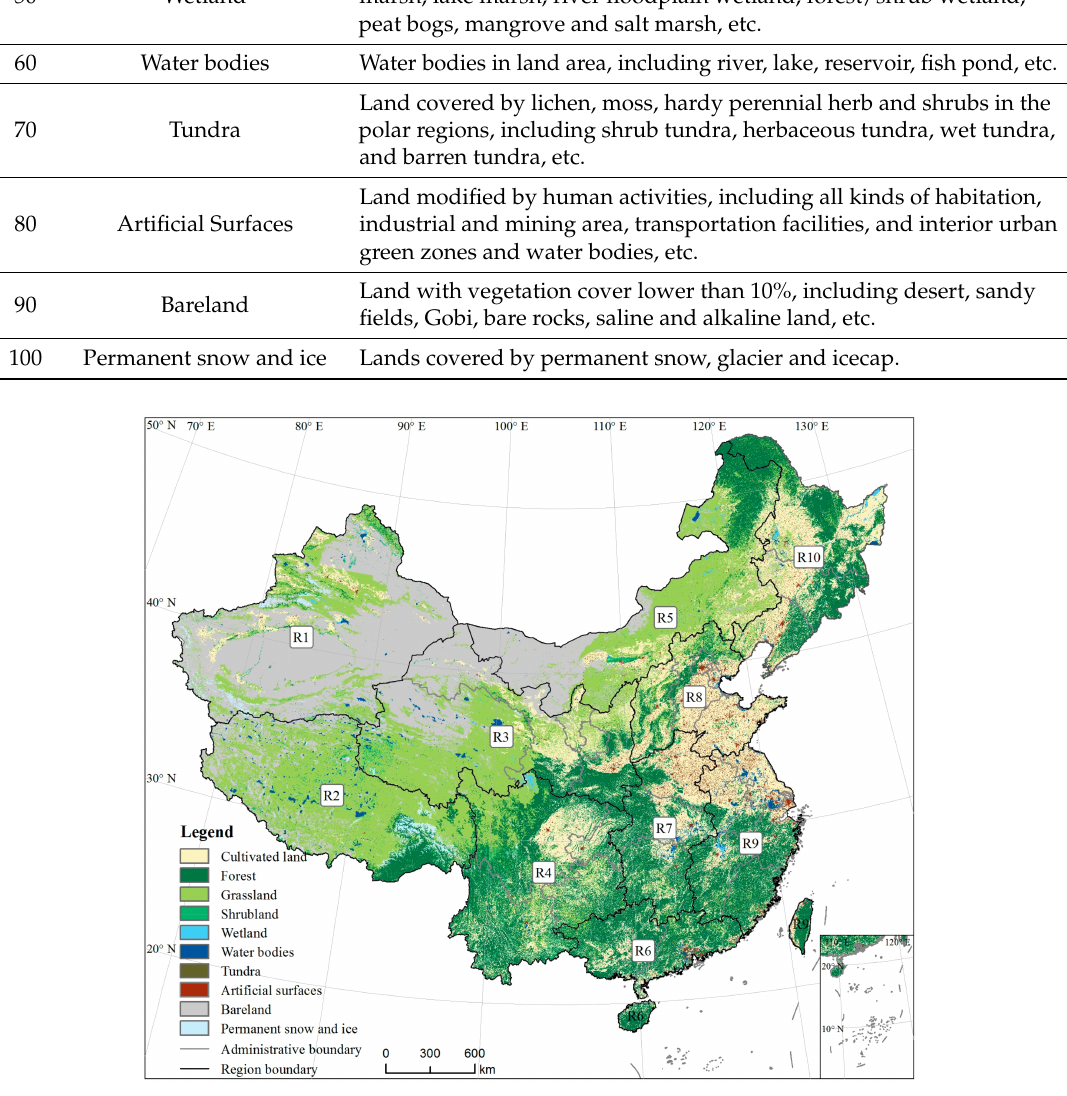
Figure 1. Regional stratification for GlobeLand30 2010 accuracy assessment over China. The boundaries of 10 geographic strata are shown in black. The labels “R1–R10” identify the regions used to geographically stratify sample data (e.g., R1 = Region